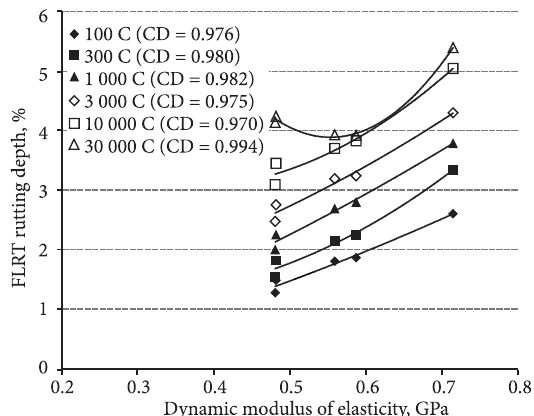
Fig. 5. Excellent relationships between dynamic modulus and FLRT rutting depth ( f = 25.0 Hz, T = +46.1 o